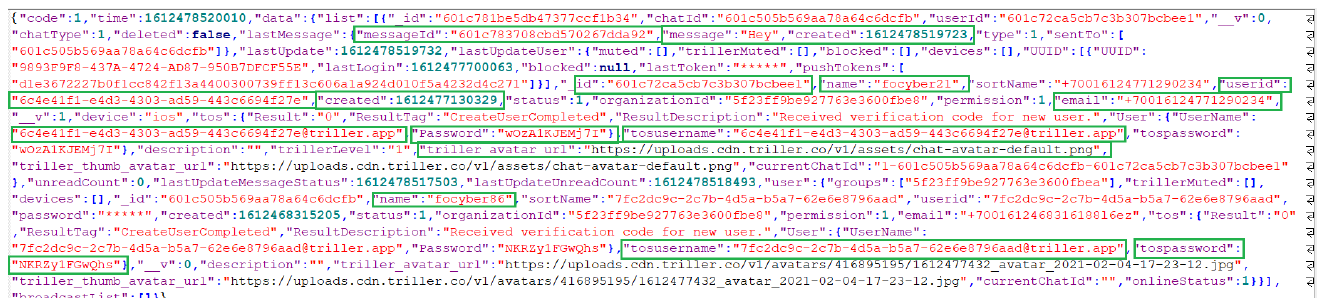
Figure 21. The content of chat-related storage on Triller as shown in DB Browser for SQLite.